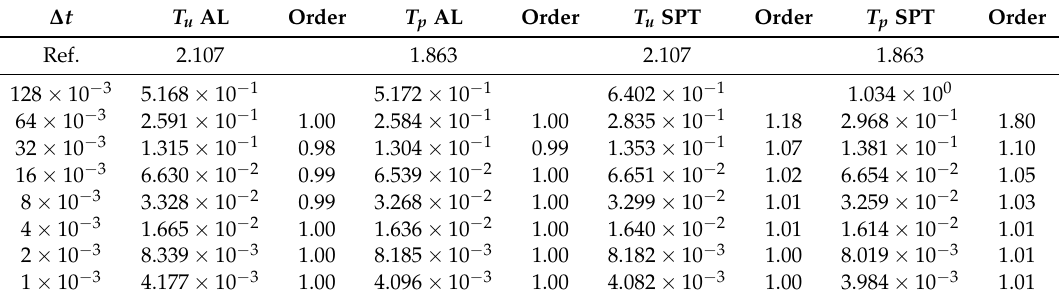
Table 4. Temporal convergence of the error on the velocity and the pressure for the augmented Lagrangian and the rotational pressure-correction methods—Gear 1 scheme for the Couette flow. ∆ t T u AL